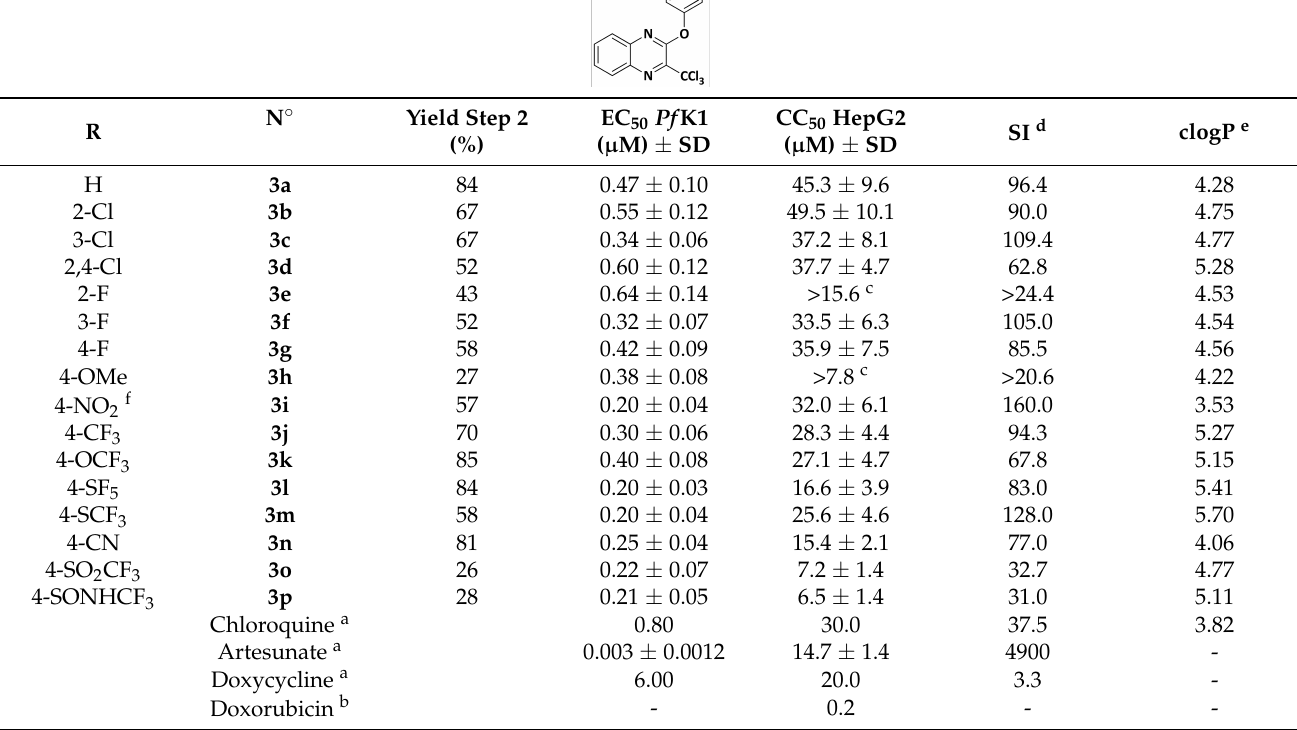
Reaction yields, antiplasmodial activity, HepG2 cytotoxicity, and clogP of the 3-phenoxy-2- trichloromethylquinoxalines 3a–3p .